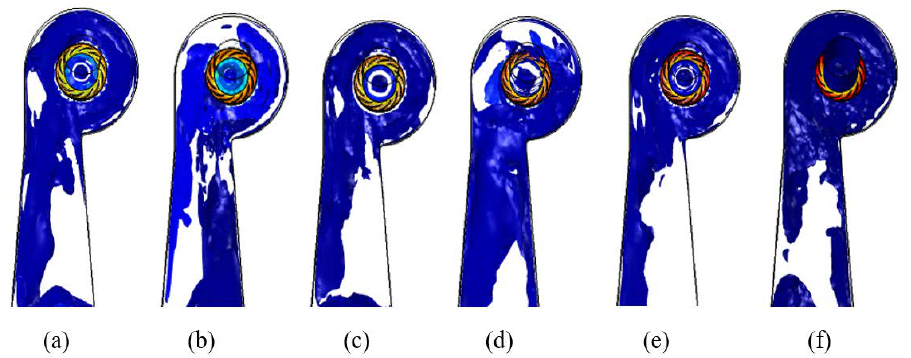
Figure 6. Velocity isosurface in the runner and draft tube for different rotational speeds with H = 32.8 m: ( a ) N = 750 rpm; ( b ) N = 1050 rpm; ( c ) N = 1500 rpm; ( d ) N = 1600; ( e ) N = 1800